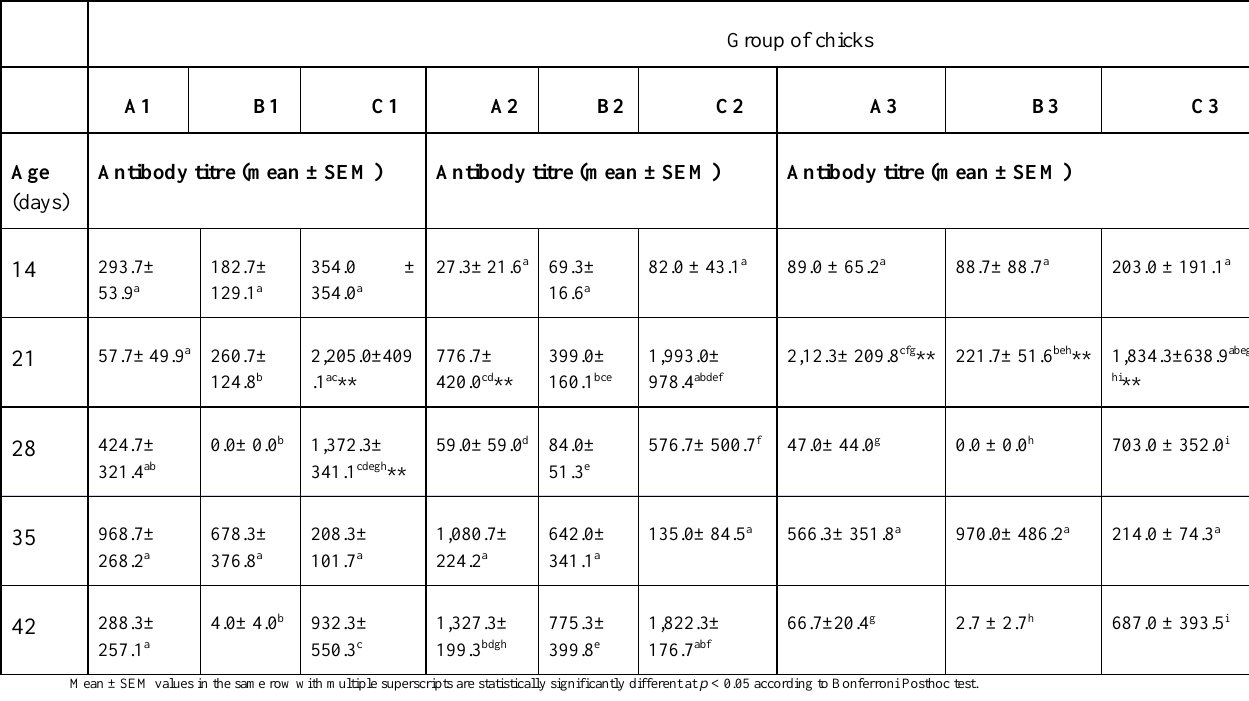
Table 1. Antibody responses of ISA brown pullets from three commercial hatcheries to different doses of avian influenza H5 inactivated vaccine administered at 14 and 28 days of age via the intramuscular route.